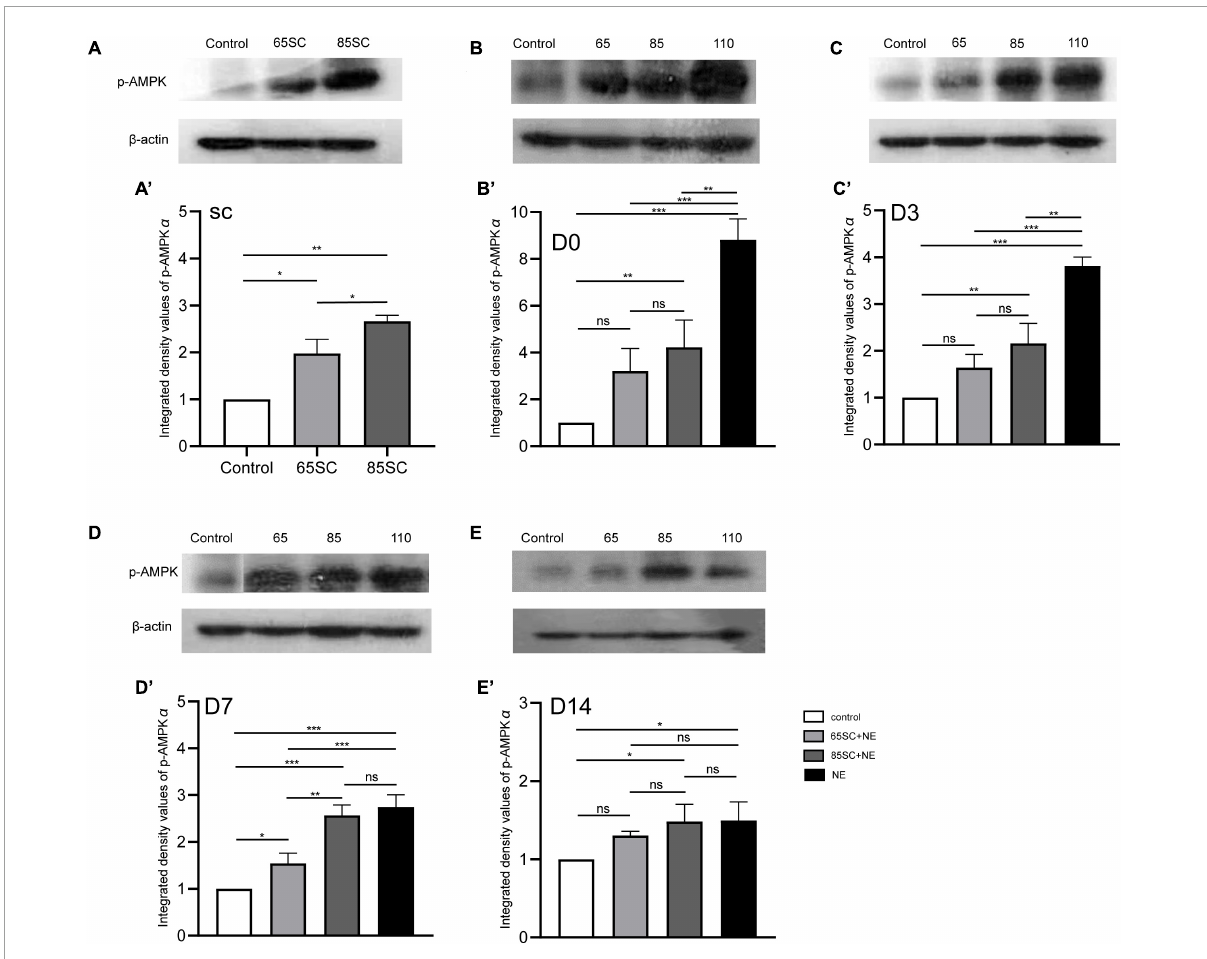
FIGURE9 The expression of the p-AMPK protein in the cochlea of mice varied in each group at different time point. (A,A’) p-AMPK protein expression increased in the SC groups after sound conditioning, and the 85SC group showed higher expression than the 65SC group ( p < 0.05). (B,B’) Among the four groups, it showed the highest p-AMPK protein expression in the NE group ( p < 0.001), followed by the 85SC+NE group at D0 ( p < 0.01); there was no statistical difference between the 65SC+NE group and the control group ( p > 0.05); and the NE group’s protein gray value was significantly higher than the 65SC+NE group ( p < 0.001) and the 85SC+NE group ( p < 0.01). (C , C’) The expression of p-AMPK protein reduced in each experimental group at D3. (D , D’) The p-AMPK protein level in the NE group decreased obviously at D7, but there was no significant change when comparing to the 85SC+NE group ( p > 0.05). (E , E’) The p-AMPK protein expression in the 85SC+NE group and NE group were higher than the control group at D14 ( p < 0.05). * p < 0.05, ** p < 0.01 *** p <